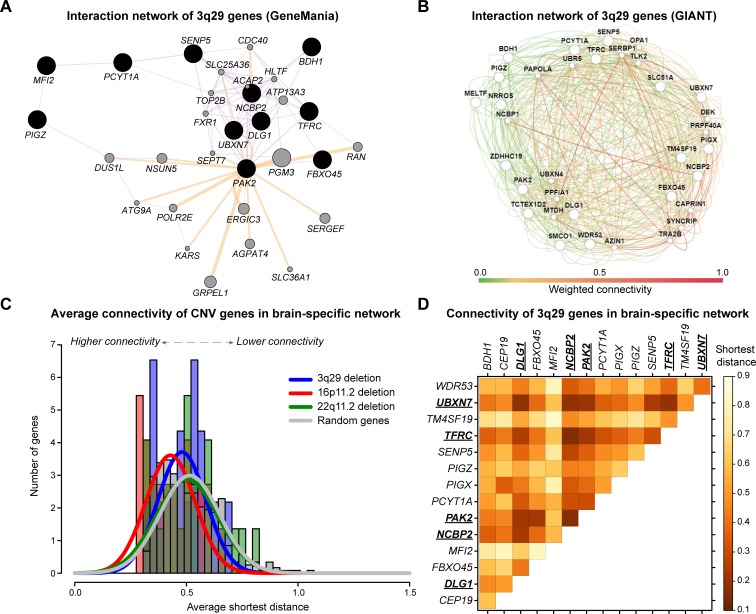
Connectivity of 3q29 genes in human gene interaction databases.(A) Genetic interactions of 3q29 genes in the context of a general human gene interaction network (GeneMania). The strongly connected component includes 11/21 total 3q29 genes. Black-shaded nodes represent the input 3q29 genes, while grey nodes represent connector genes in the network. Edge color represents the interaction data source (purple: co-expression, orange: predicted interaction), while edge thickness represents weighted scores for each interaction. (B) Genetic interactions of 19 genes in the 3q29 region in the context of a brain-specific human gene interaction network (GIANT). Large nodes represent the input 3q29 genes, while small nodes represent connector genes in the network. Edge color represents the weighted score for each interaction, from low connectivity (green) to high connectivity (red). (C) Histograms and smoothed normal distributions showing the average connectivity among genes in the 3q29 region (blue) along with two other large CNVs, 16p11.2 (red) and 22q11.2 deletion (green), within a brain-specific gene interaction network. Average connectivity is measured as the shortest weighted distance between two genes, with lower distances representing higher connectivity. Genes within the 3q29 and 22q11.2 deletions were not significantly more connected to each other (p>0.05, one-tailed Mann-Whitney test with Benjamini-Hochberg correction) than random sets of 21 genes throughout the genome (grey). However, genes within the 16p11.2 region were significantly more connected to each other than the random gene sets (p = 0.003, one-tailed Mann-Whitney test with Benjamini-Hochberg correction). (D) Pairwise connectivity of individual 3q29 genes within a brain-specific gene interaction network, excluding six genes not present in the network (RNF168, ZDHHC19, LRRC33, OSTalpha, SMCO1, and TCTEX1D2). Average connectivity is measured as the shortest weighted distance between two genes, with lower values representing higher connectivity. Underlined genes have a higher average connectivity (p<0.05, one-tailed Mann-Whitney test with Benjamini-Hochberg correction) to other genes in the region compared with random sets of 21 genes throughout the genome.